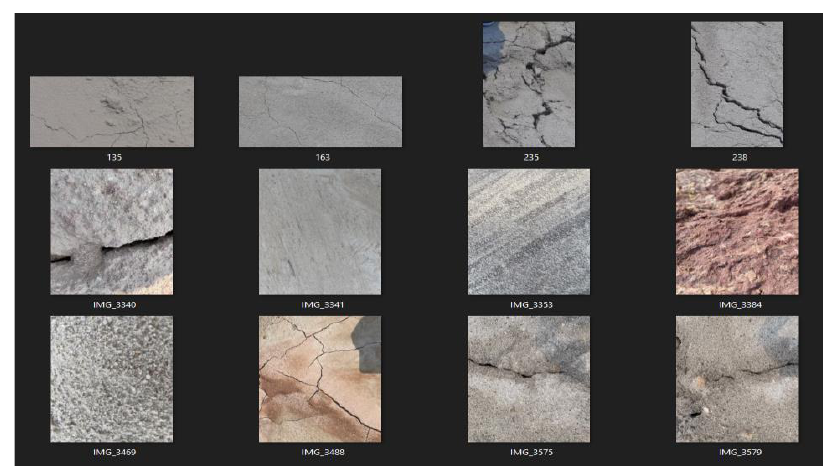
Figure 10. Real-time sample crack images used in the experiment.